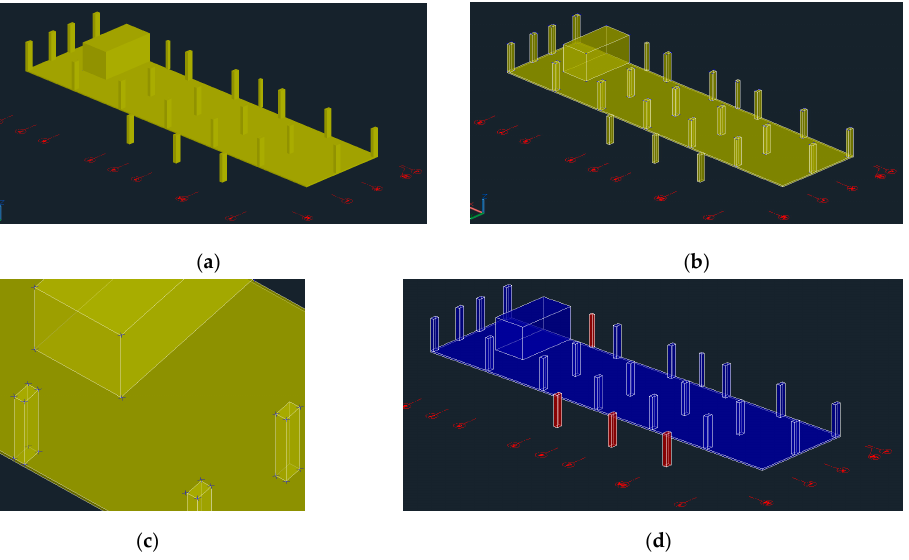
Figure 4. ( a ) Planned 3D model; ( b ) as-built edges superimposed on the planned model; ( c ) close-up of the superimposition of the as-built edges shown by blue crosses; ( d ) schedule comparison.